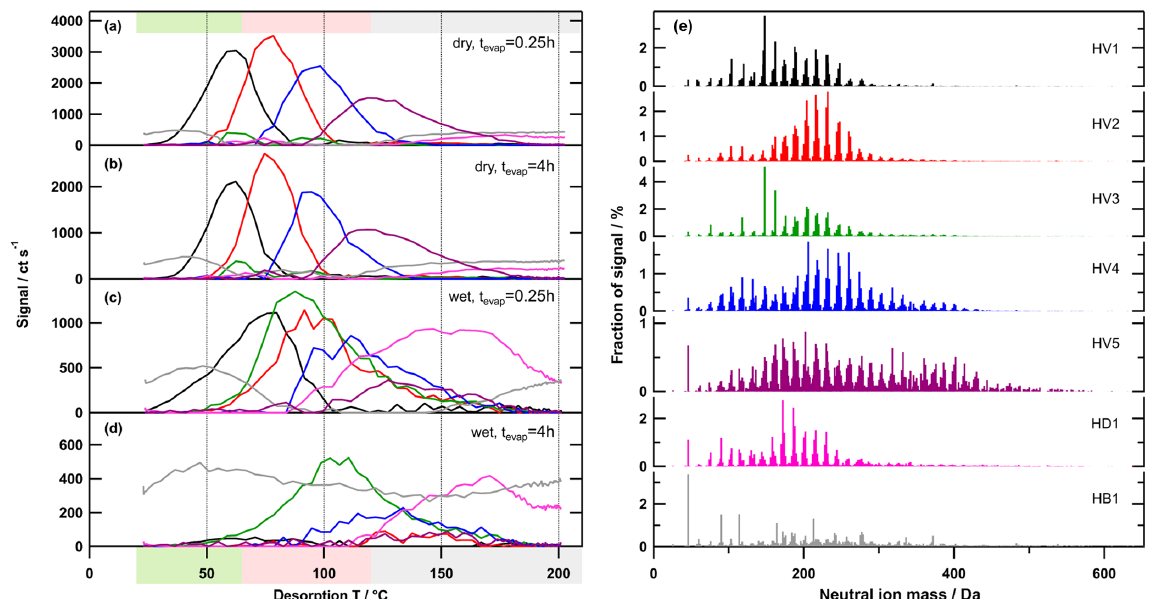
Figure 7. Factor thermograms (a–d) and factor mass spectra (e) for the 7-factor solution of the high-O : C case. Each factor mass spectrum is normalised. The colour code is the same for both panels. Background colours in the panel on the left indicate the volatility classification derived from T max – C ∗ sat calibrations (green – SVOC; red – LVOC; and grey – ELVOC). Note the different scaling for the y axes in (a) – (d)